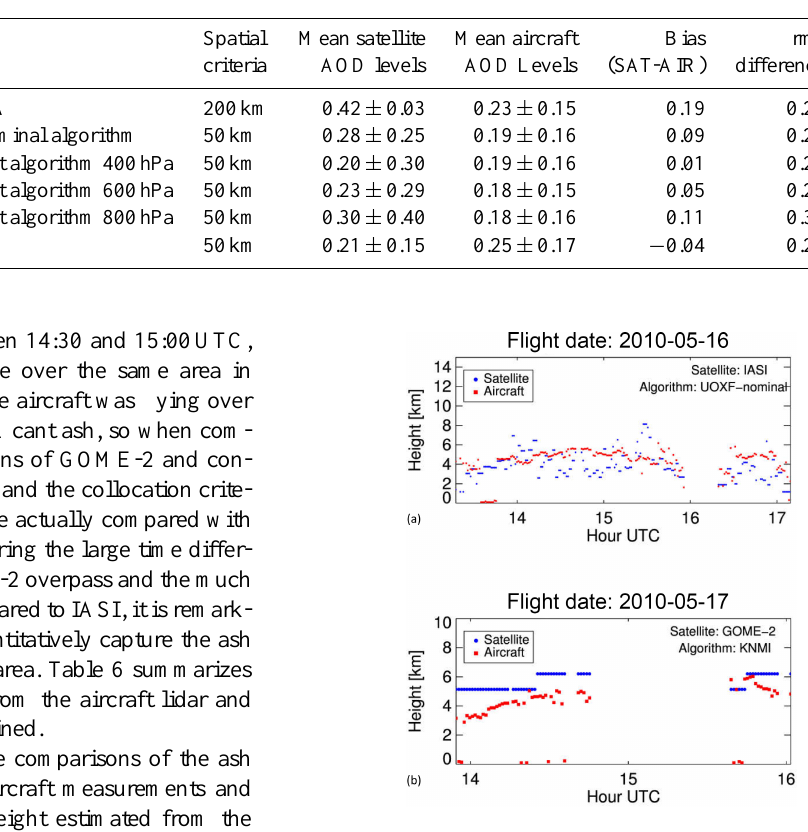
Table 6. Statistical mean values and associated standard deviation for the airborne lidar and the satellite ash optical depth estimates at 550nm presented for collocated measurements.